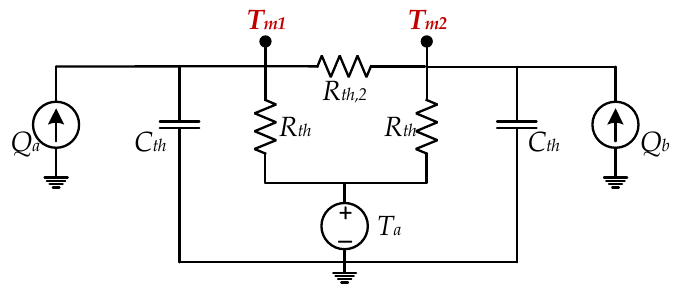
Figure 9. Simplified thermal circuit.